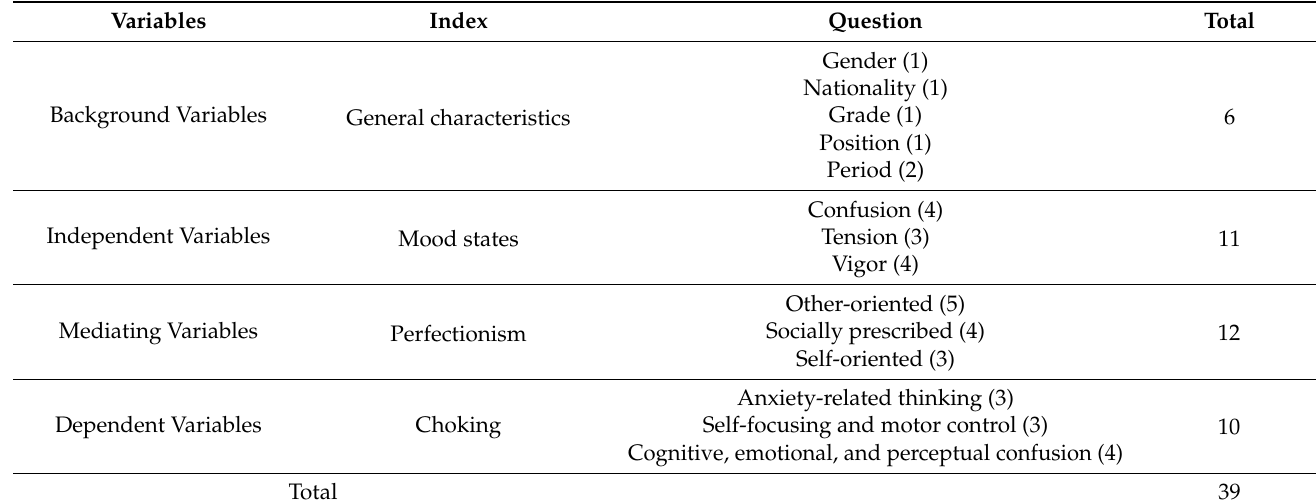
Table 2. Contents of the